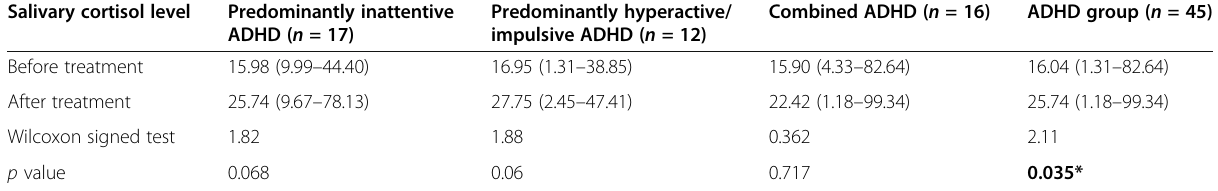
Table 3 Salivary cortisol level of the ADHD group before treatment and 1 month after treatment with methylphenidate Salivary cortisol level Predominantly inattentive ADHD ( n =